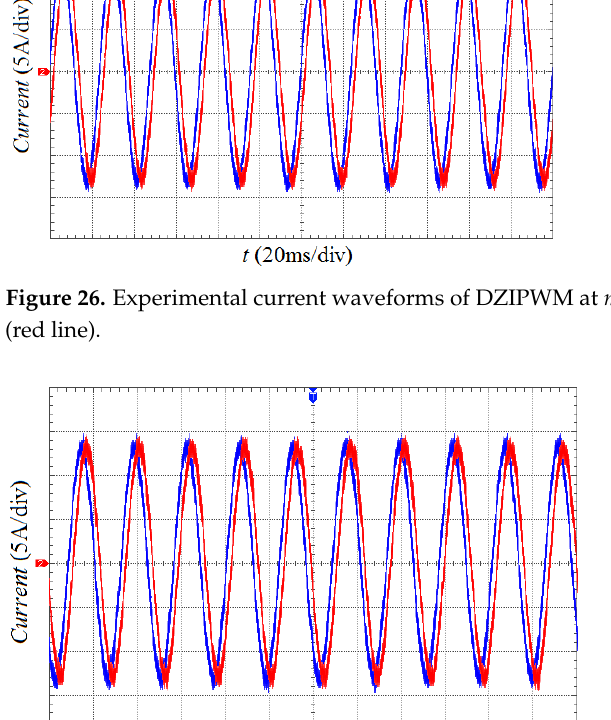
Figure 27. Experimental current waveforms of DZICMV at m = 0.9703; current i a (blue line) and i u (red line).